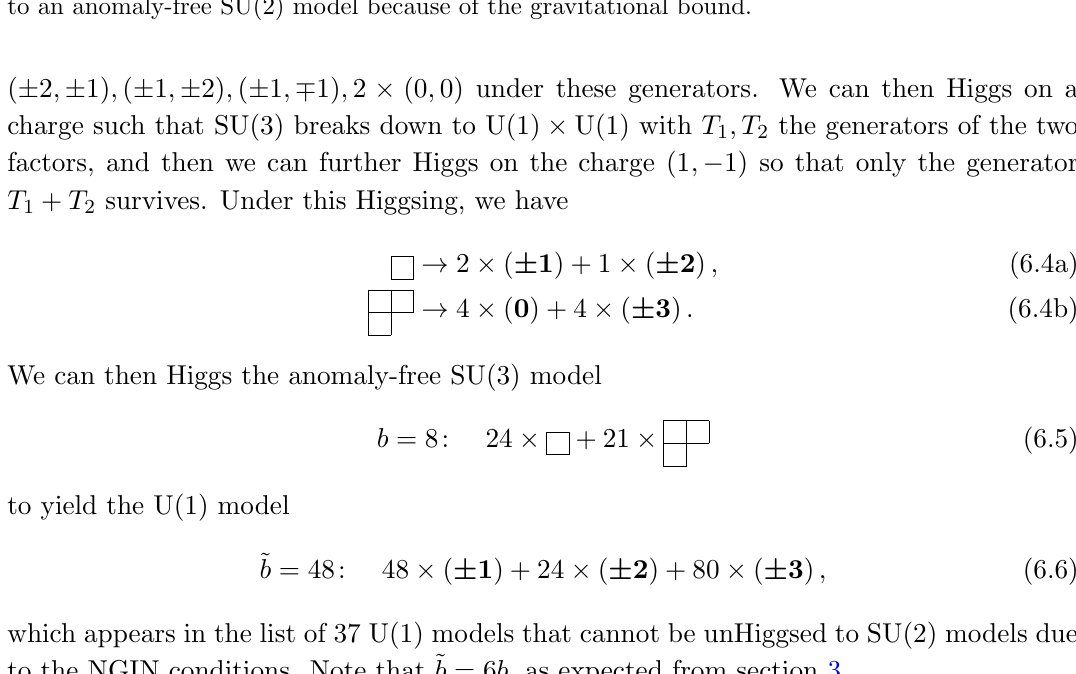
Table 4 . Anomaly-free, exchangeable T = 0 U(1) models with j q j (cid:20) 3 that cannot be unHiggsed to an anomaly-free SU(2) model because of the gravitational